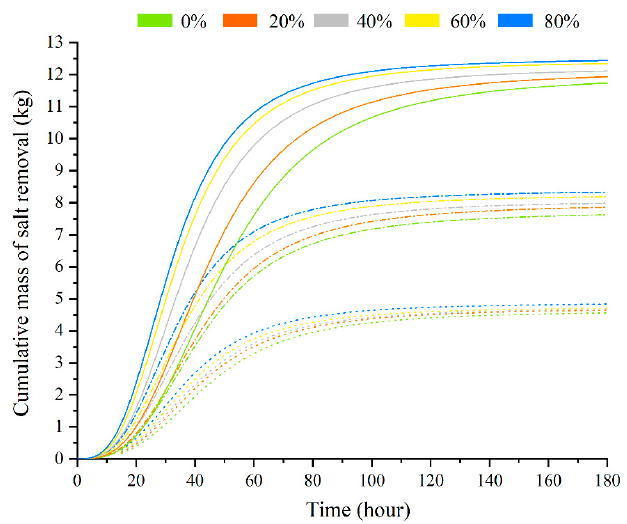
Figure 8. Cumulative mass of salt removal in three leaching amounts (the dotted line, dash dot line, and solid line refer to 80, 120, and 160 mm respectively) with five mixture rates.